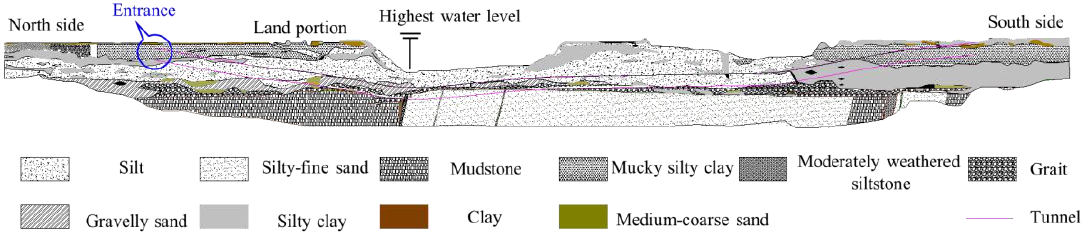
Figure 4. Geological profile of the Nanjing Yangtze River tunnel.